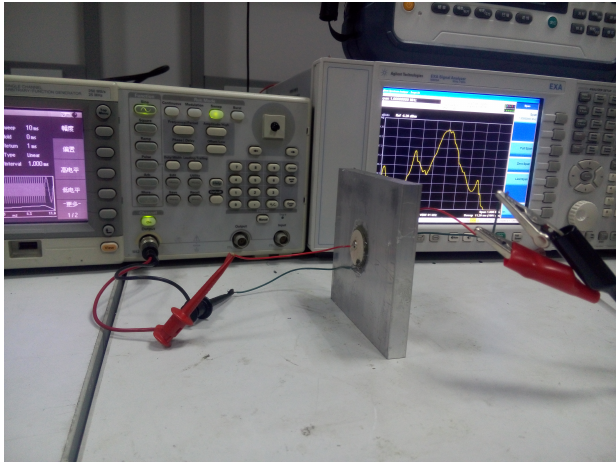
Figure 9. Experimental platform for power